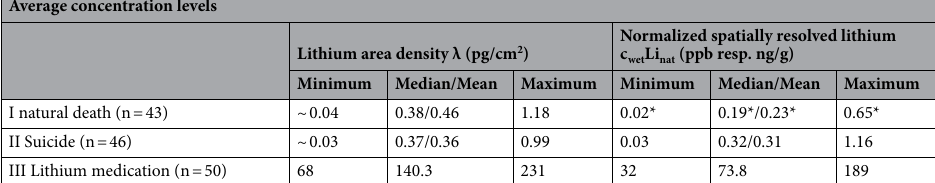
Table 2. Average brain lithium levels. *Based on sample analysis of n = 29 of n = 43.